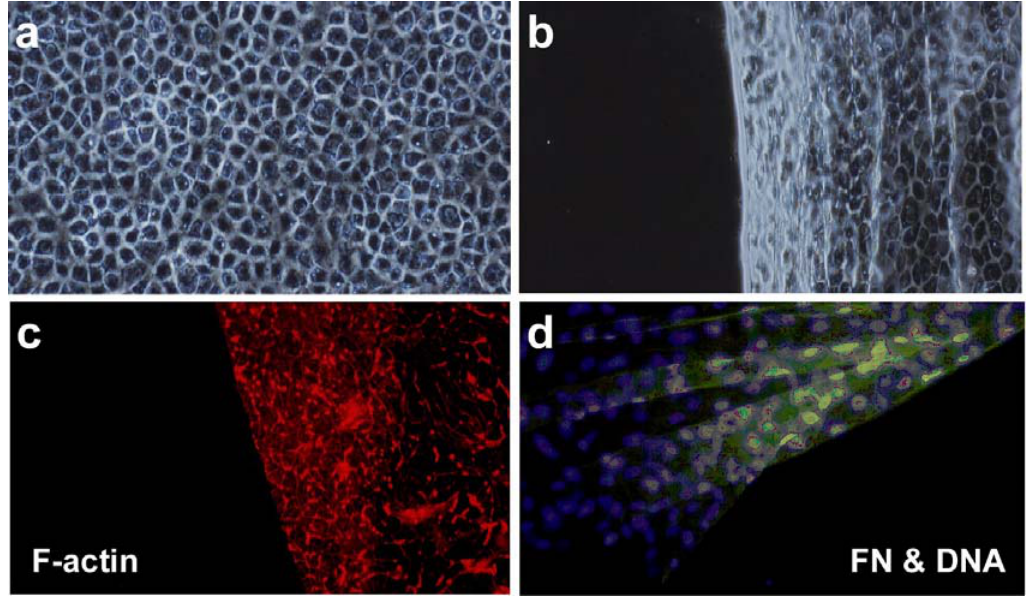
Figure 3. Bovine aortic endothelial cell sheets detached from ( a ) an ungrafted tissue culture polystyrene (TCPS) dish and ( b ) poly( N -isopropylacrylamide) grafted dish after low-temperature treatment. The detached cell sheet was fixed and stained with ( c ) rhodamine-phalloidin and ( d ) double-stained with an anti-fibronectin antibody and a fluorescent dye for nuclei. Fibronectin matrix has been found in the cell sheet, and no remnant has been observed on the surface where the cell sheet detached (the right bottom corner in ( d